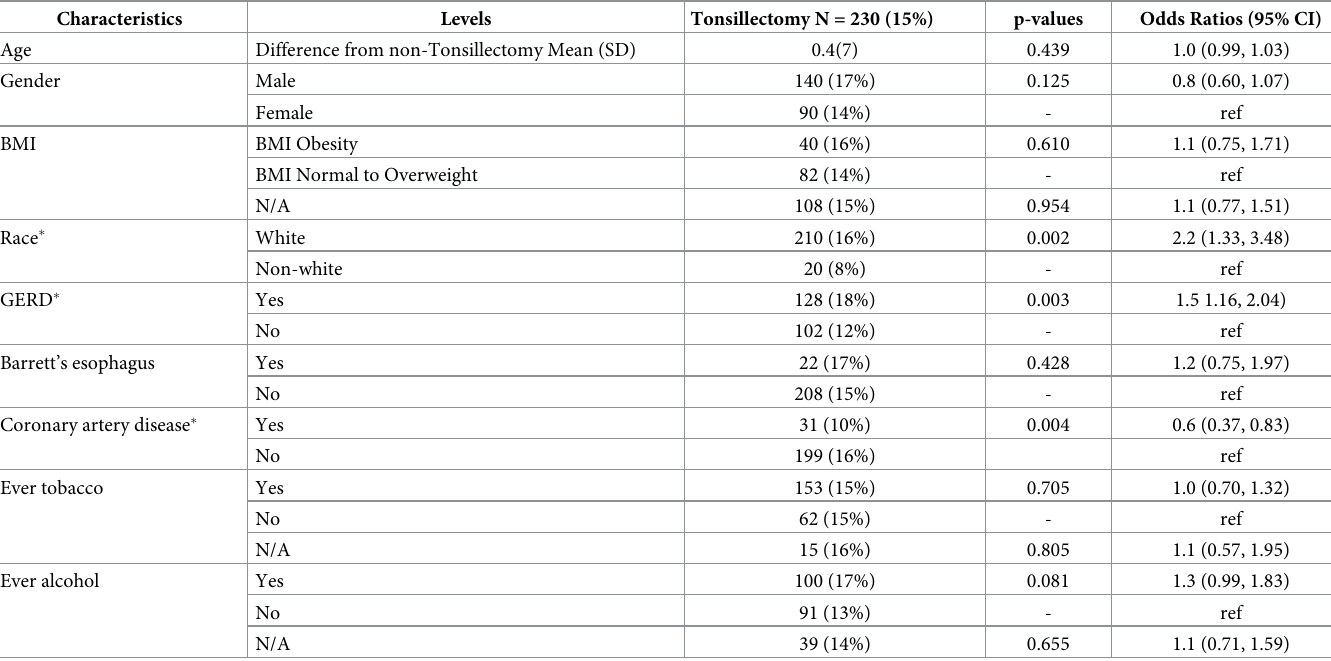
Table 2. Association between various known risk factors for EAC and prior tonsillectomy are presented here.